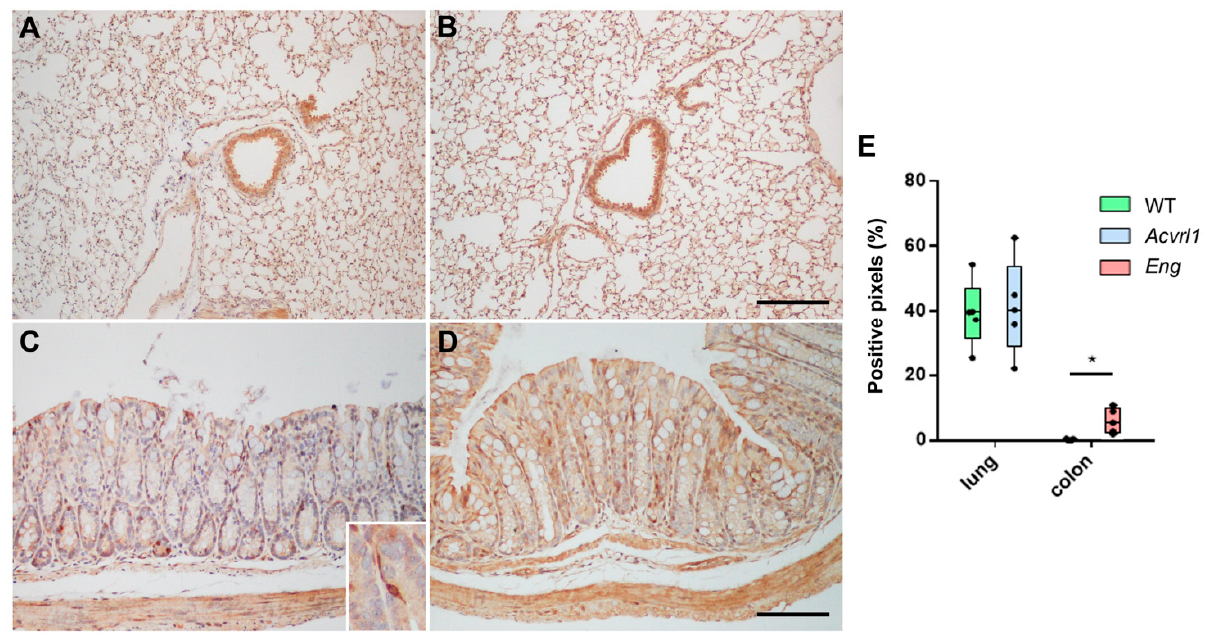
Figure 3. AM expression in endoderm ‐ derived organs as measured by qRT ‐ PCR. No differences were found among genotypes in the lungs, stomach, or pancreas. Box plots represent the interquar ‐ tile range with the median as a horizontal line. Whiskers encompass the maximum and minimum values of the population. Dots represent individual animals. *: p < 0.05.